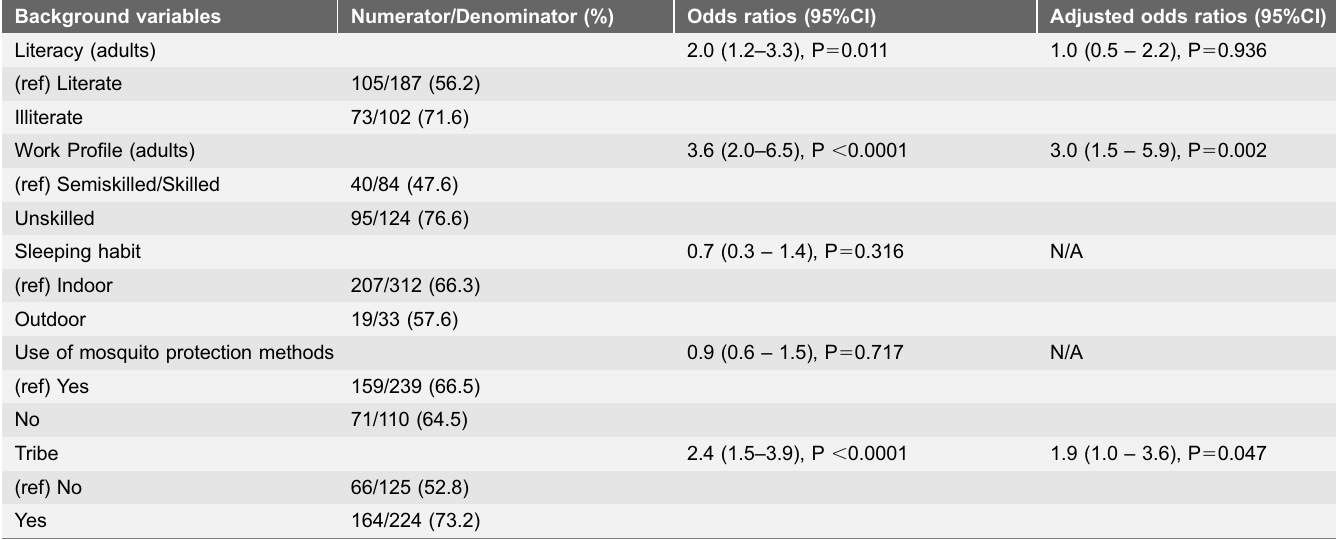
Table 3. Univariate and multivariate logistic regression analysis of different background variables associated with complicated malaria at Maharani Hospital Jagdalpur, Chhattisgarh, India.